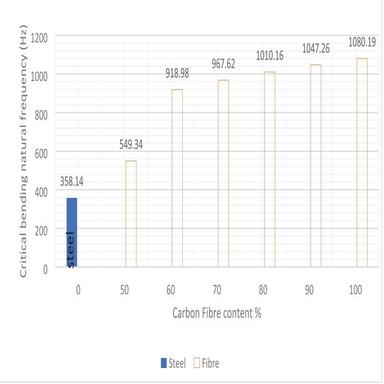
Critical bending natural frequency of steel and composite drive shaft.